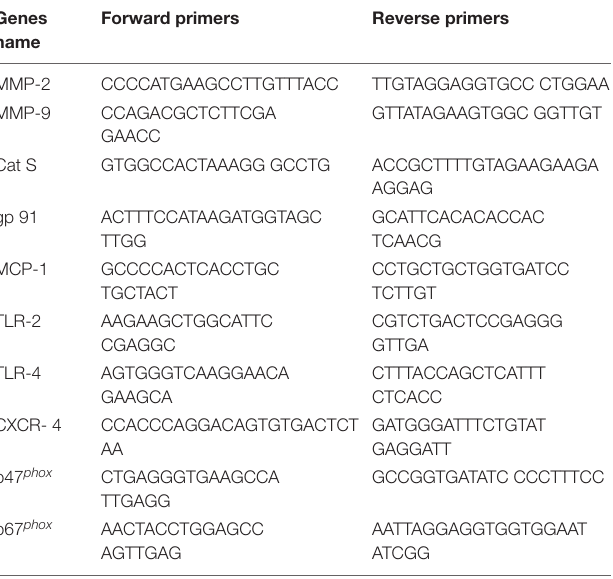
TABLE 1 | Primer sequences for mice used for quantitative real-time